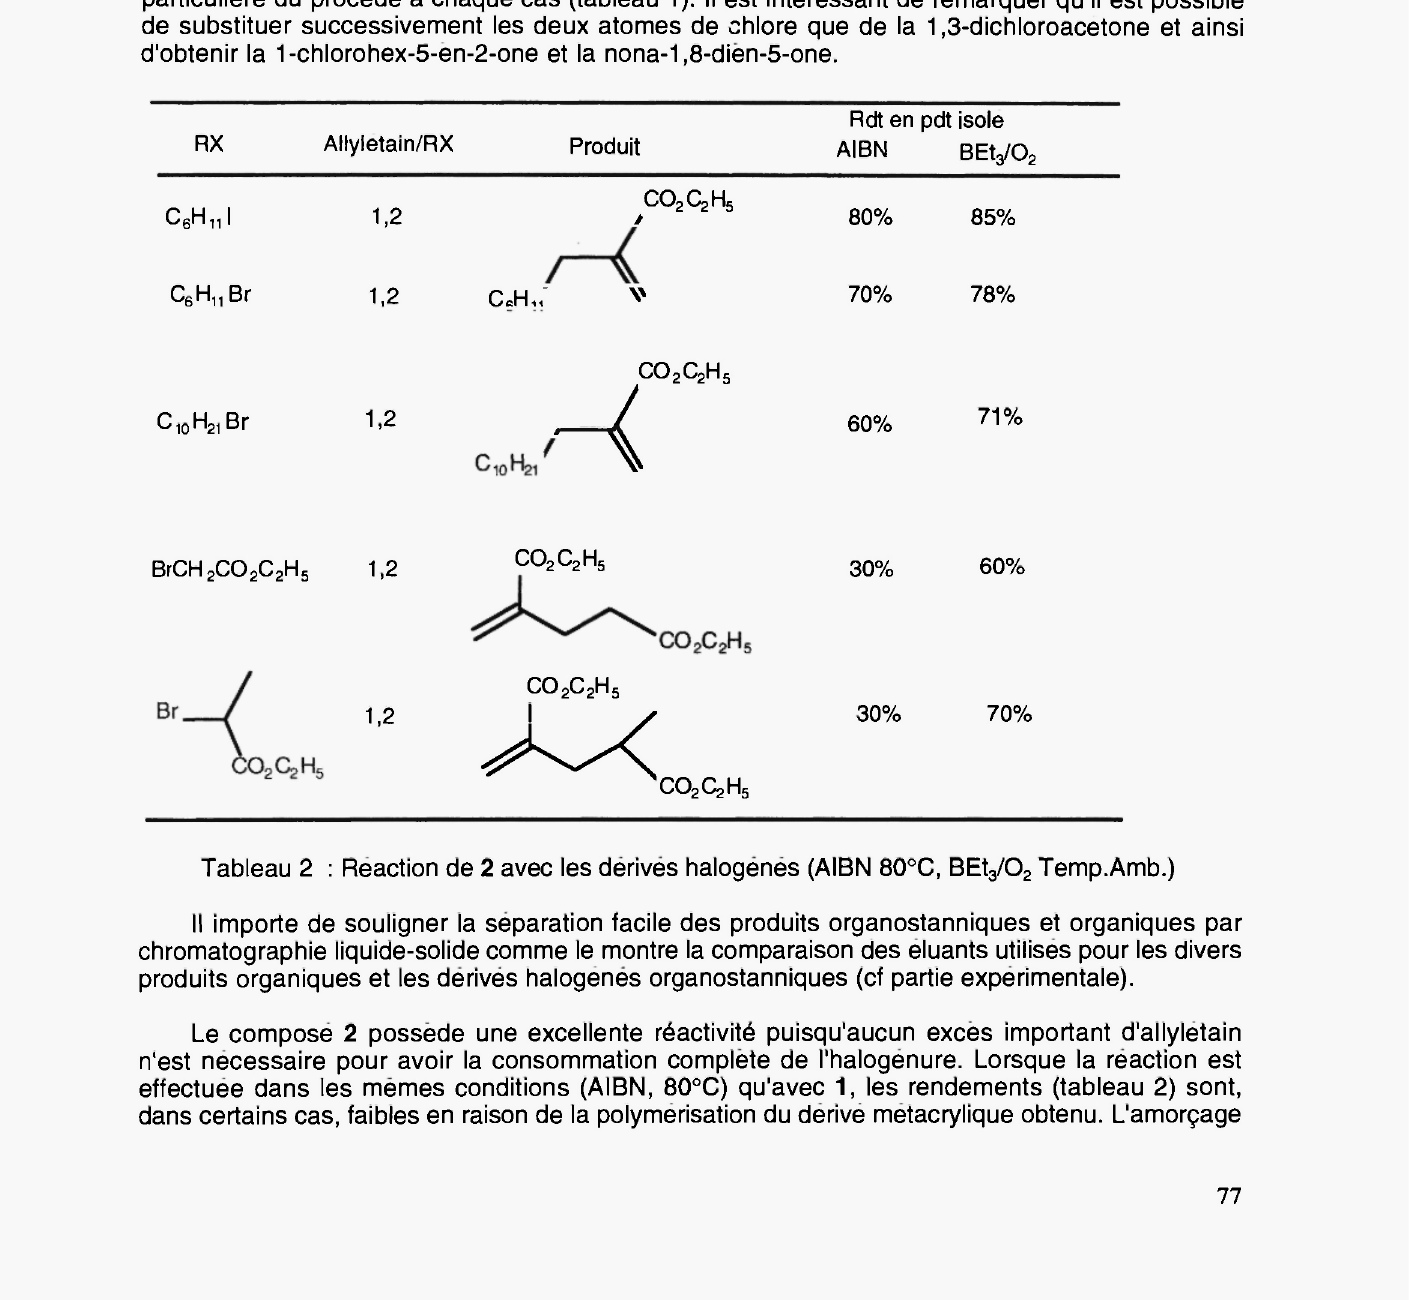
Tableau 2 : Reaction de 2 avec les derives halogenes (AIBN 80°C, BEt 3 /0 2